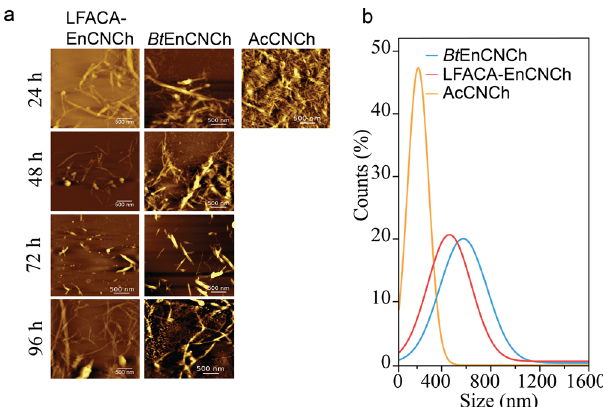
Fig. 3 Nanochitin morphology. a AFM images of nanoparticles produced by LPMO oxidative cleavage at different times. The images have 3 × 3 μ m dimensions and show the nanoparticles obtained from the α -Chitin cleavage with LFACA-LPMO and Bt LPMO at times of 24, 48, 72, and 96 h. b Size distribution of EnCNCh particles produced with LFACA-LPMO (red line), Bt LPMO (blue line) and HCl hydrolysis (yellow line) using α -Chitin as substrate. Size distribution was calculated with the length of 100 particles from each